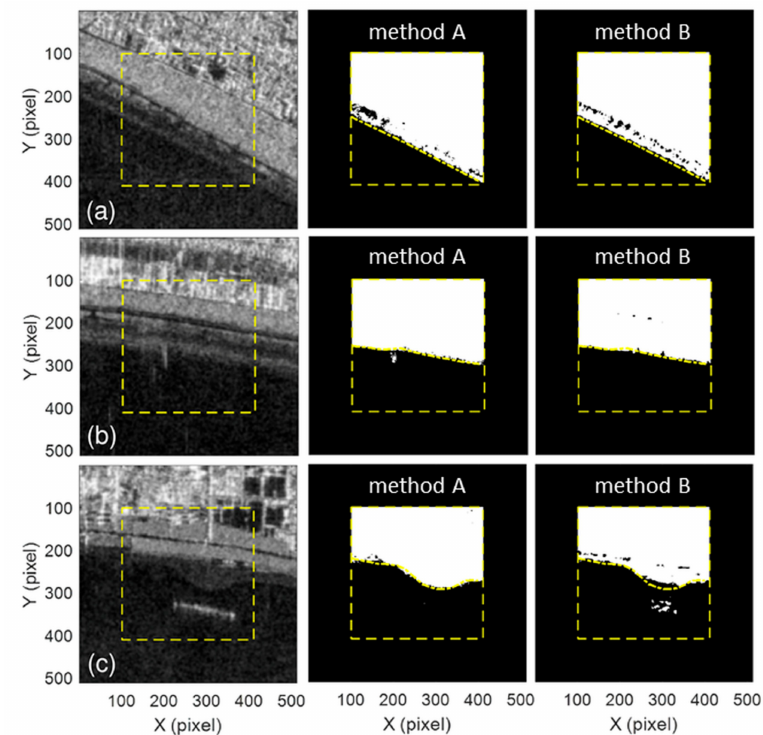
Figure 9. Examples of the classification results produced by the proposed NN model. Panels in the left column show the modified SAR image with a square frame with a yellow dashed line indicating a 310 × 310 square domain in which the proposed NN model was applied. The panels in the middle and right columns show the results of land (white) and sea (black) classification using Methods A and B, respectively. Yellow curved lines in these panels indicate the eye-detected shoreline. Pixel size is around 1.4 m in the Y (azimuth) direction and 1.9 m in the X (range) direction.